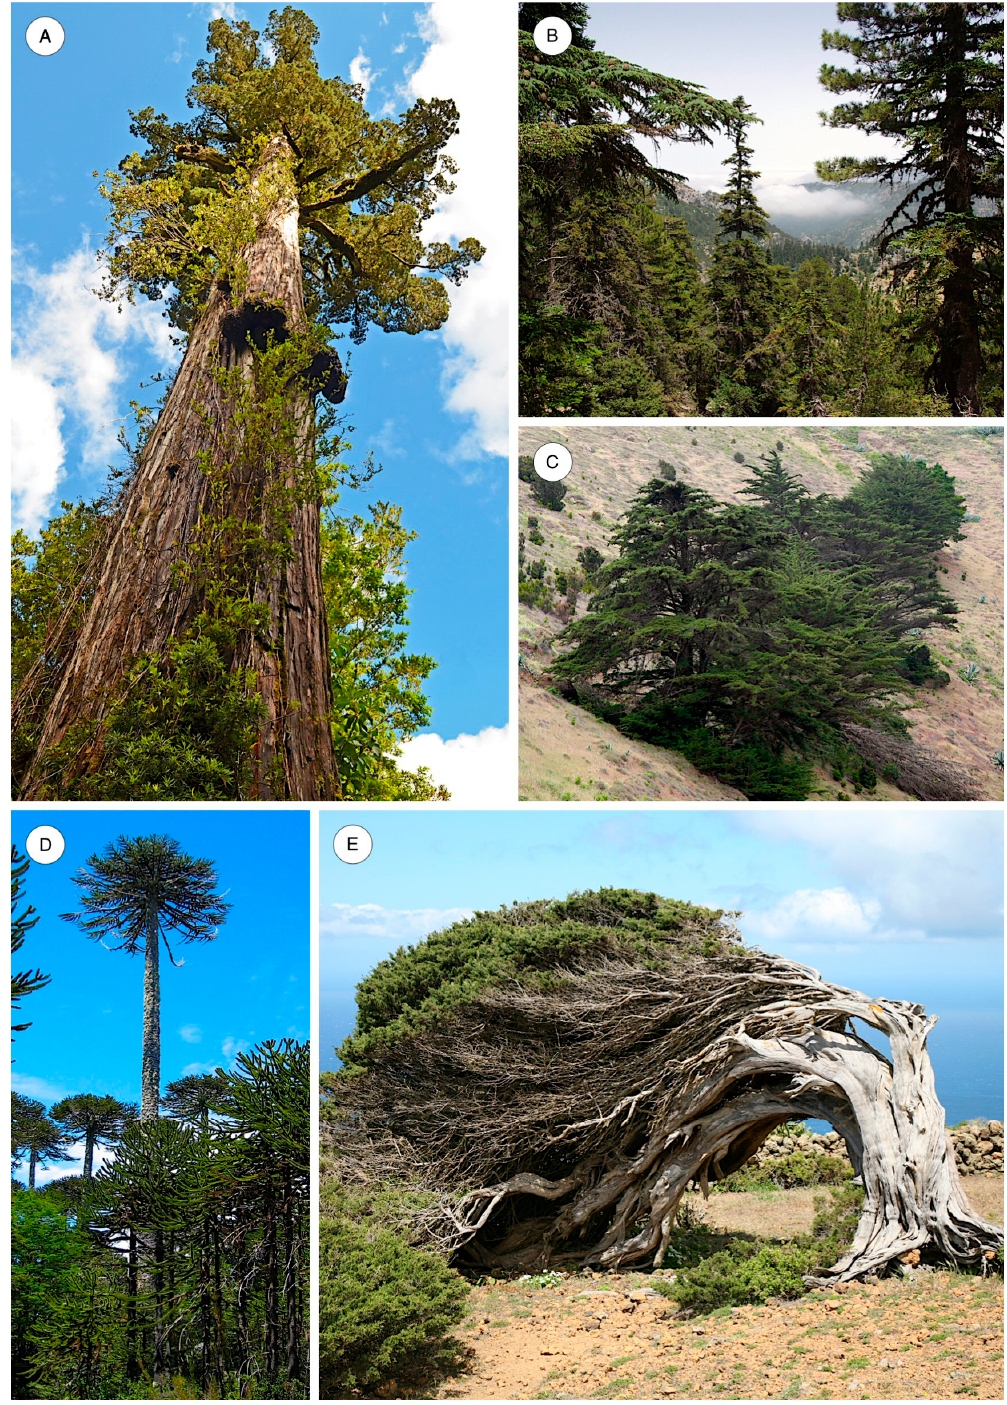
Figure 2. Coniferous gymnosperms. ( A ) Fitzroya cupressoides (Molina) I.M.Johnst.; ( B ) Mixed conifer forest of Abies pinsapo subsp . marocana (Trab.) Emb. and Maire, Cedrus atlantica (Endl.) Manetti ex Carrière and Pinus nigra subsp. salzmannii (Dunal) Franco; ( C ) Juniperus cedrus , Webb and Berthel.; ( D ) Araucaria araucana (Molina) K.Koch; ( E ) Juniperus canariensis , Guyot and Mathou.